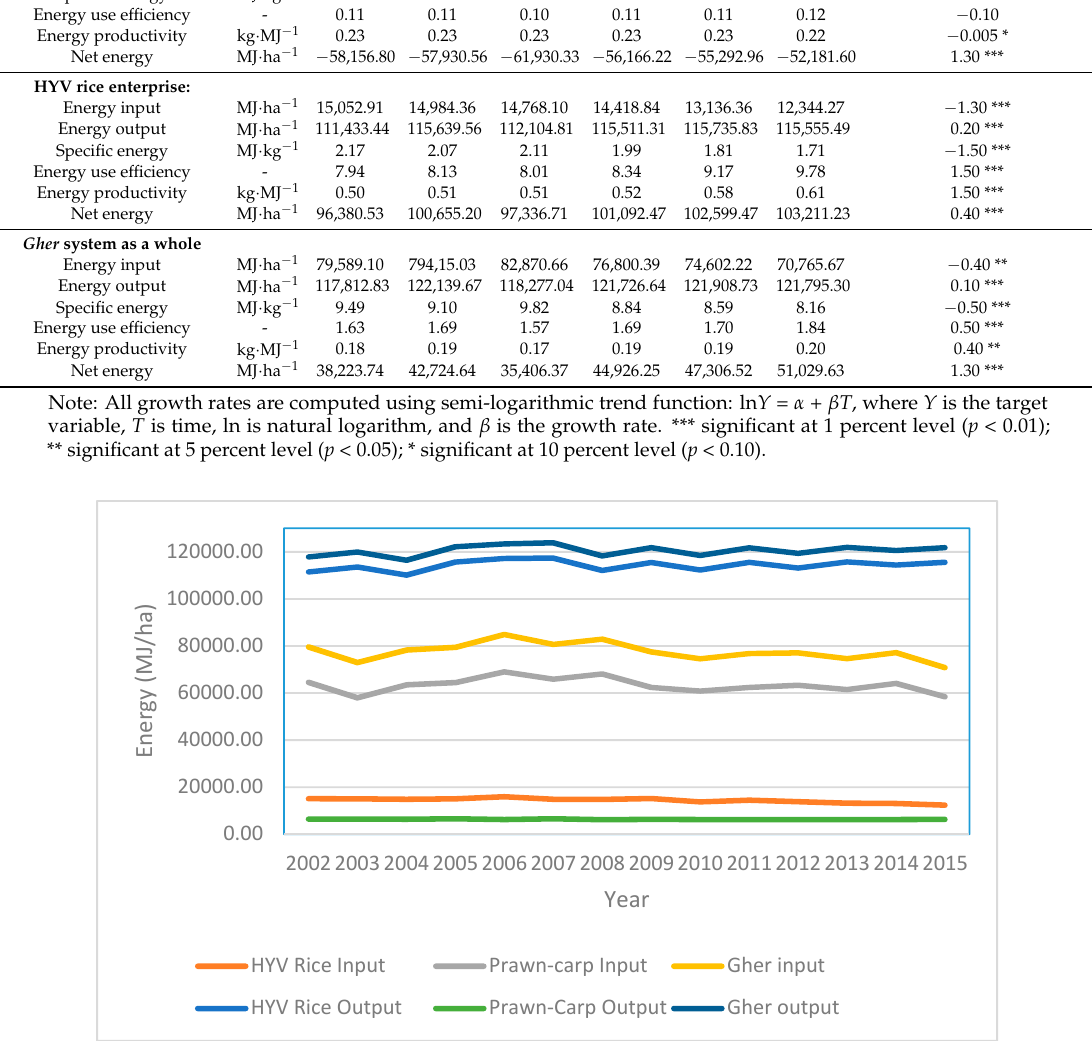
Figure 1. Trends in energy inputs and outputs of the gher farming system.